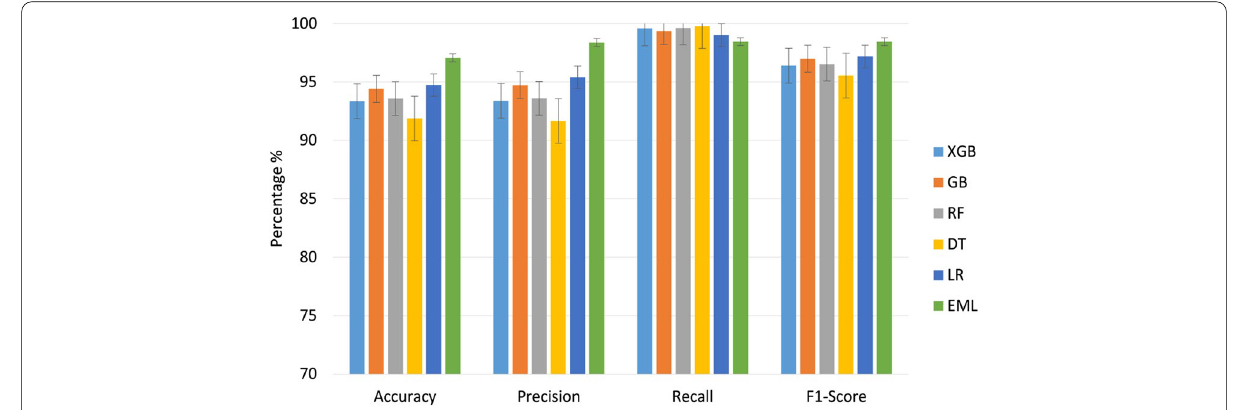
Fig. 2 Performance Metrics Comparison of Machine Learning Algorithms